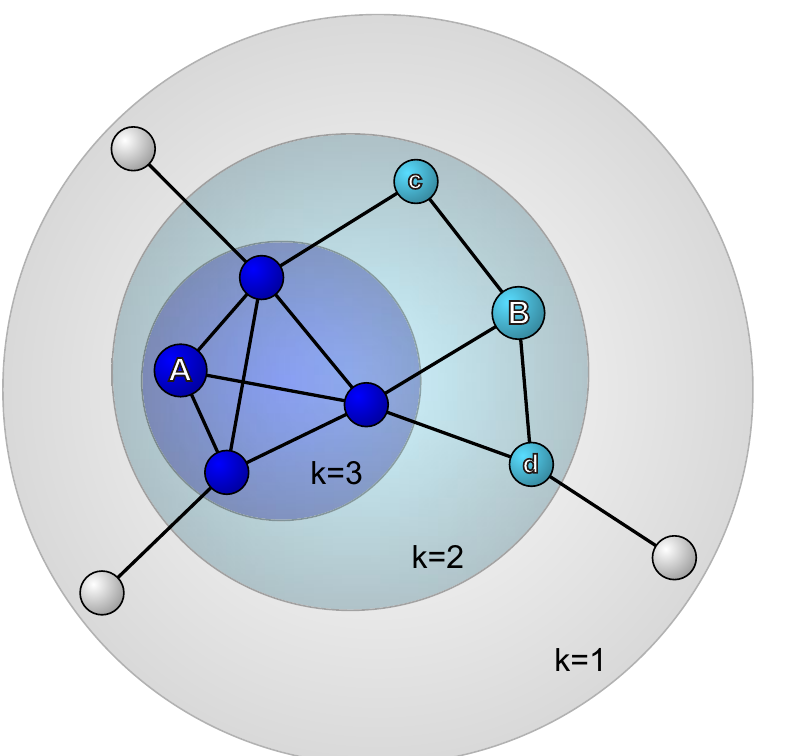
Figure 1. A hypothetical network graph of 10 people. Social network embeddedness was measured by k -core score, the highest value of k among k -core groups to which people belonged. A k -core group consists of people who have at least k social connections with group members. Even though A and B’s social network sizes are the same (3), only A can be a member of the 3-core group and has a higher k-core score than B (3 vs.